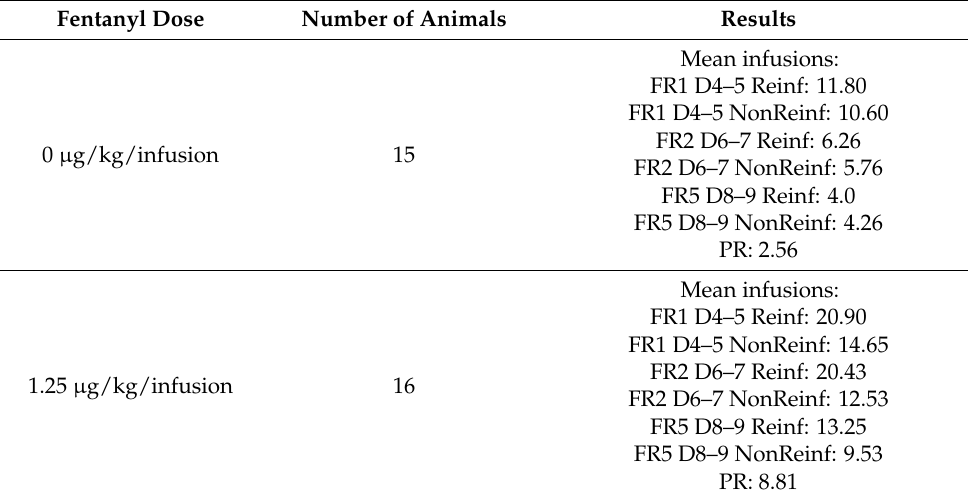
Figure 2. Fentanyl intravenous self-administration. ( A ) Mean number of infusions across 2 days at fixed ratio (FR) 1, FR2, and FR5 schedules of reinforcement, reinforced (Reinf, filled bars and circles) vs. non-reinforced (Non Reinf, empty bars and circles) responses, at 0, 1.25, and 2.5 μg/kg/infusion (error bars represent S.E.M., ** p < 0.01, * p < 0.05, n = 10 – 16/group). ( B ) Mean infusion breakpoint over 2 days at a progressive ratio schedule of reinforcement at 0, 1.25, and 2.5 μg/kg/infusion (error bars represent S.E.M., **** p < 0.0001, ** p < 0.01, n = 10 – 16/group). Data are collapsed by sex. Table 1. Fentanyl intravenous self-administration. Mean number of infusions self-administered at fixed ratio (FR) 1, FR2, FR5, and progressive ratio (PR) schedules of reinforcement at 0, 1.25, and 2.5 μg/kg/infusion .